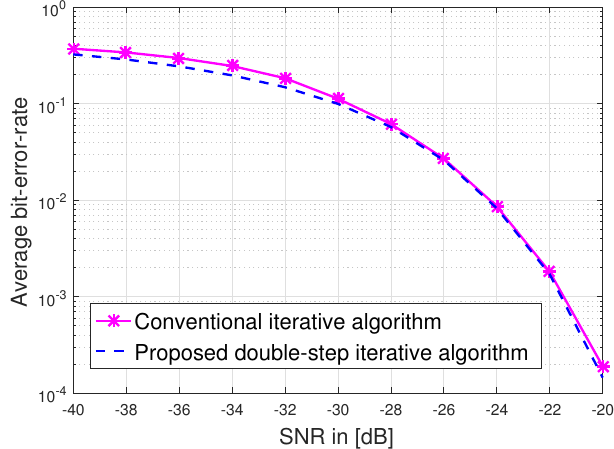
Figure 8. Average bit−error−rate versus SNR in a RIS system at N s = 4, N t = 8 N R = 256.